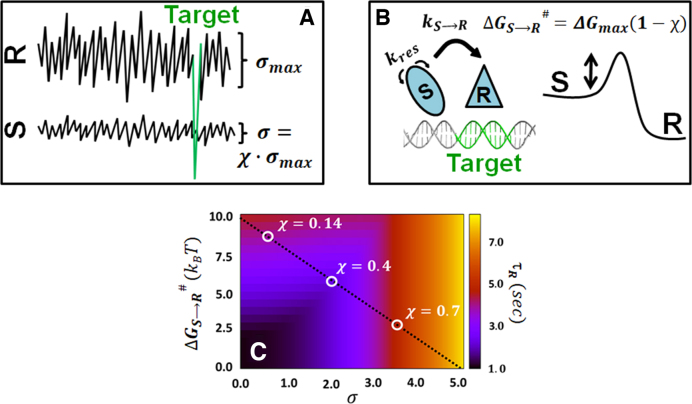
A schematic representation of the presented model for a DBP finding and binding its DNA target site. (A) DBP search of the DNA via 1D diffusion, during which the protein is in the S binding mode, is governed by the ruggedness of the protein–DNA energy landscape, σ. The energetic ruggedness is related to the DNA sequence and to the ability of the protein to form specific hydrogen bonds; thus, it is correlated with the similarity index, χ. The ruggedness and frustration are linked by the relation \documentclass[12pt]{minimal}
\usepackage{amsmath}
\usepackage{wasysym}
\usepackage{amsfonts}
\usepackage{amssymb}
\usepackage{amsbsy}
\usepackage{upgreek}
\usepackage{mathrsfs}
\setlength{\oddsidemargin}{-69pt}
\begin{document}
}{}${\rm{\sigma \ }} = {\rm{\ \chi }} \cdot {{\rm{\sigma }}_{{\rm{max}}}}$\end{document} where \documentclass[12pt]{minimal}
\usepackage{amsmath}
\usepackage{wasysym}
\usepackage{amsfonts}
\usepackage{amssymb}
\usepackage{amsbsy}
\usepackage{upgreek}
\usepackage{mathrsfs}
\setlength{\oddsidemargin}{-69pt}
\begin{document}
}{}${{\rm{\sigma }}_{{\rm{max}}}}$\end{document} is the variation of the sliding energy potential in the recognition mode. The target site (marked green) is illustrated by a deep energy well in the recognition model. (B) Schematic presentation of the transition from the search (S) to the recognition (R) mode at the target site with a typical transition rate of kS→R while having to cross an energy barrier of \documentclass[12pt]{minimal}
\usepackage{amsmath}
\usepackage{wasysym}
\usepackage{amsfonts}
\usepackage{amssymb}
\usepackage{amsbsy}
\usepackage{upgreek}
\usepackage{mathrsfs}
\setlength{\oddsidemargin}{-69pt}
\begin{document}
}{}$\Delta G_{s \to R}^\ddagger$\end{document}. The term τres ( = kres−1) is the average time the protein spends on one base pair during sliding. The free energy barrier \documentclass[12pt]{minimal}
\usepackage{amsmath}
\usepackage{wasysym}
\usepackage{amsfonts}
\usepackage{amssymb}
\usepackage{amsbsy}
\usepackage{upgreek}
\usepackage{mathrsfs}
\setlength{\oddsidemargin}{-69pt}
\begin{document}
}{}$\Delta G_{s \to R}^\ddagger$\end{document} depends on the similarity index through the relation \documentclass[12pt]{minimal}
\usepackage{amsmath}
\usepackage{wasysym}
\usepackage{amsfonts}
\usepackage{amssymb}
\usepackage{amsbsy}
\usepackage{upgreek}
\usepackage{mathrsfs}
\setlength{\oddsidemargin}{-69pt}
\begin{document}
}{}$\Delta G_{s \to R}^\ddagger$\end{document} = ΔGmax(1 − χ), where ΔGmax represents a maximal barrier for highly frustrated protein–DNA binding. (C) The total time to recognize the target site, τR, is affected by the time scale of both 1D diffusion and the transition from S to R. These two process have opposite dependencies on the similarity index. Accordingly, σ and \documentclass[12pt]{minimal}
\usepackage{amsmath}
\usepackage{wasysym}
\usepackage{amsfonts}
\usepackage{amssymb}
\usepackage{amsbsy}
\usepackage{upgreek}
\usepackage{mathrsfs}
\setlength{\oddsidemargin}{-69pt}
\begin{document}
}{}$\Delta G_{s \to R}^\ddagger$\end{document} are negatively correlated. The dotted line expresses the values of \documentclass[12pt]{minimal}
\usepackage{amsmath}
\usepackage{wasysym}
\usepackage{amsfonts}
\usepackage{amssymb}
\usepackage{amsbsy}
\usepackage{upgreek}
\usepackage{mathrsfs}
\setlength{\oddsidemargin}{-69pt}
\begin{document}
}{}$\Delta G_{s \to R}^\ddagger$\end{document} and of \documentclass[12pt]{minimal}
\usepackage{amsmath}
\usepackage{wasysym}
\usepackage{amsfonts}
\usepackage{amssymb}
\usepackage{amsbsy}
\usepackage{upgreek}
\usepackage{mathrsfs}
\setlength{\oddsidemargin}{-69pt}
\begin{document}
}{}${\rm{\sigma }}$\end{document} when they are linked through frustration according to the proposed model, and various \documentclass[12pt]{minimal}
\usepackage{amsmath}
\usepackage{wasysym}
\usepackage{amsfonts}
\usepackage{amssymb}
\usepackage{amsbsy}
\usepackage{upgreek}
\usepackage{mathrsfs}
\setlength{\oddsidemargin}{-69pt}
\begin{document}
}{}${\rm{\chi }}$\end{document} values are marked. The total recognition times for different values of χ and \documentclass[12pt]{minimal}
\usepackage{amsmath}
\usepackage{wasysym}
\usepackage{amsfonts}
\usepackage{amssymb}
\usepackage{amsbsy}
\usepackage{upgreek}
\usepackage{mathrsfs}
\setlength{\oddsidemargin}{-69pt}
\begin{document}
}{}$\Delta G_{s \to R}^\ddagger$\end{document} are indicated by the color bar. This plot was calculated for ΔGmax, σmax and Ens of 10, 5 and 9kBT, respectively.